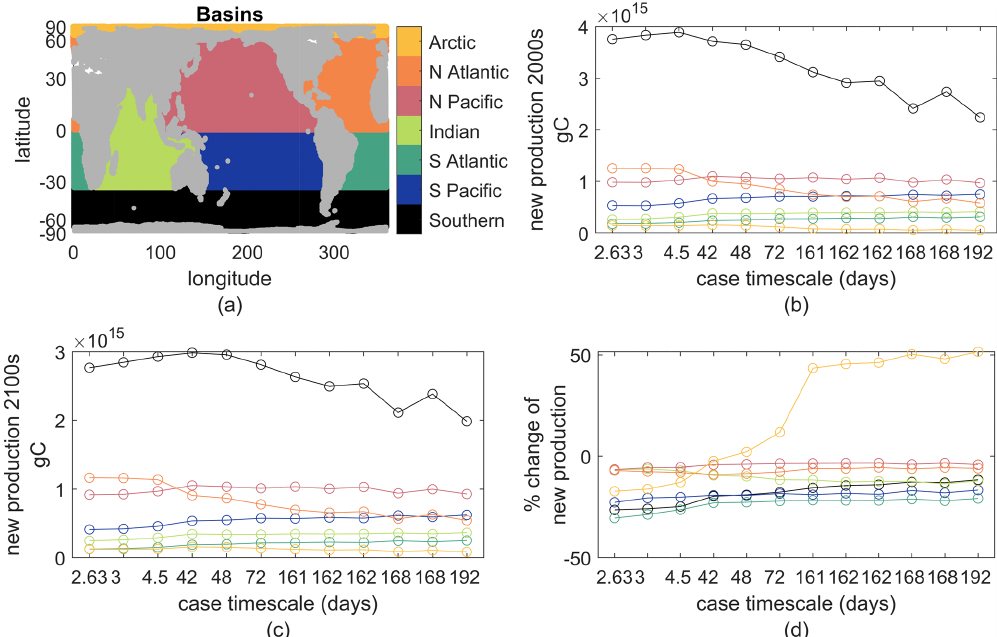
Figure B1. (a) Map of the seven basins; colors are consistent through all panels. (b) Annual new production in the top 100m in each basin for the early-21st-century climate. (c) As in (b) but for the late-21st-century climate. (d) Percent change between panels (a) and (b) . The case timescale is k N /µ + 1 /µα . The fast case is the second from the left, case timescale 3. The slow case is the fourth from the right, case timescale